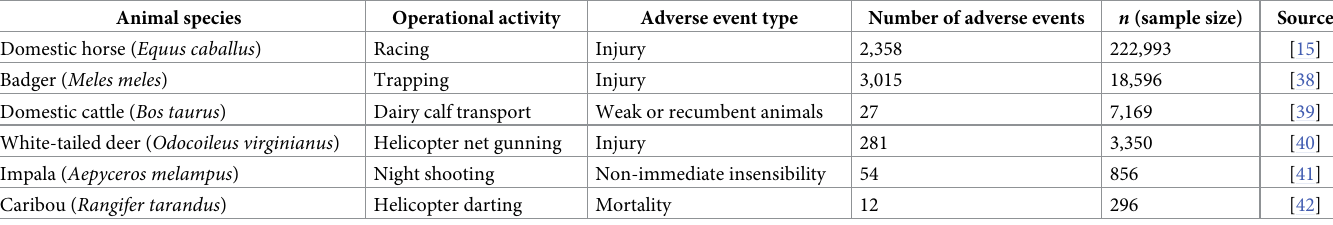
Table 1. Selected published studies reporting the frequency of adverse animal welfare events from operational activities (not research trials).